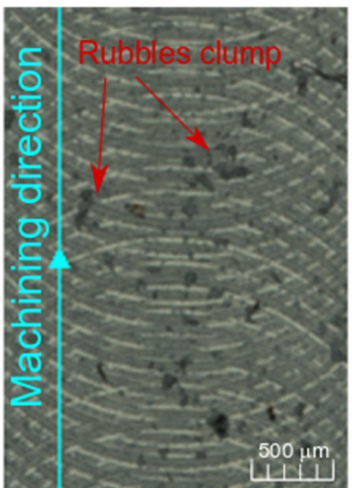
Figure 6. Rubble clumps caused by the material pullout (V c = 98 m / min in the green body with 3 wt%)